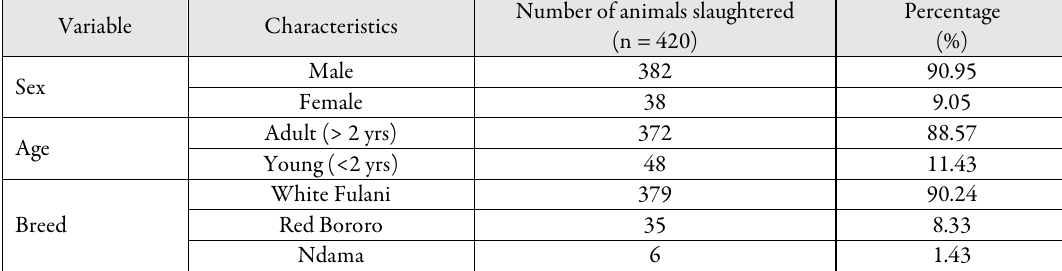
Table 1. Characteristics of cattle slaughtered in Ikpa slaughterhouse Variable